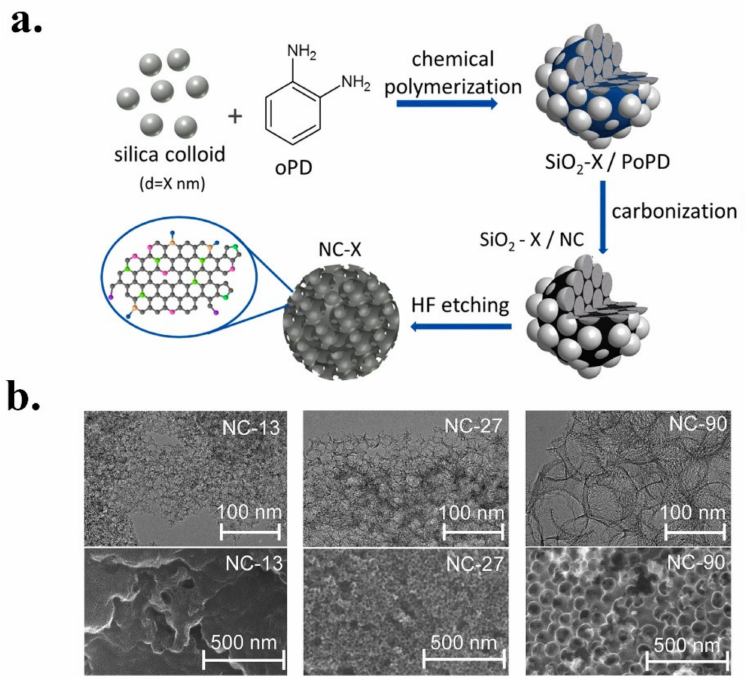
Figure 4. ( a ) Scheme of the synthesis of N-doped carbons (NC) by a sacrificial support method. ( b ) TEM and SEM images of NC with different pore sizes (13–90 nm). Adapted from